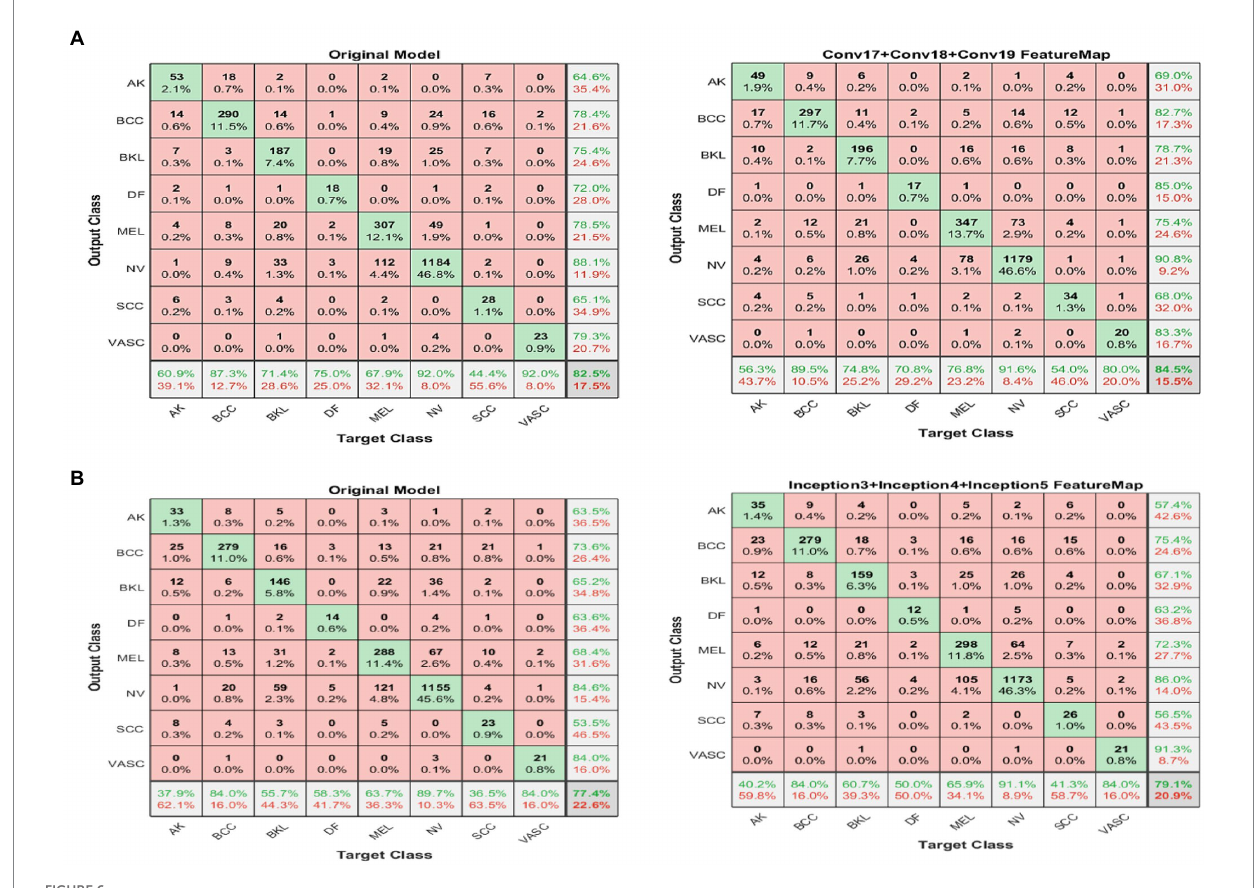
FIGURE 6 Confusion matrix (8 × 8) for the DarkNet and GoogleNet experiment (left) before and (right) after applying the proposed FFM. (A) GoogleNet and (B) DarkNet.